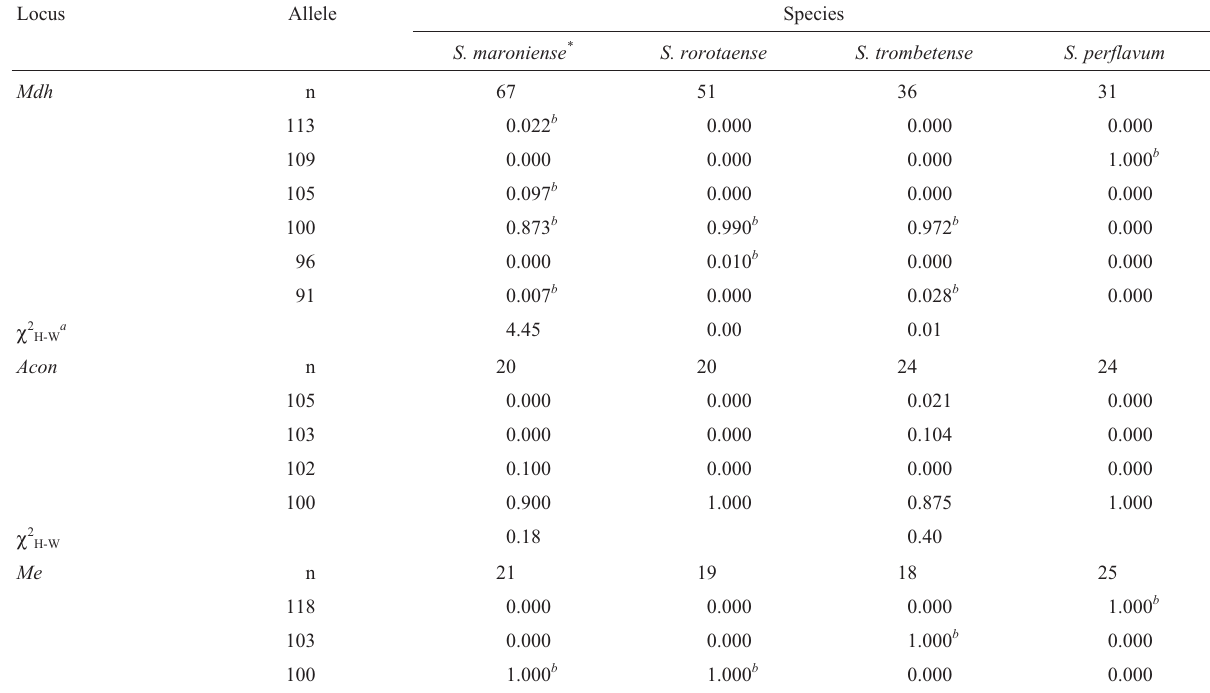
Table 1 - Allele frequencies in four species of the Simulium perflavum species group. Locus Allele